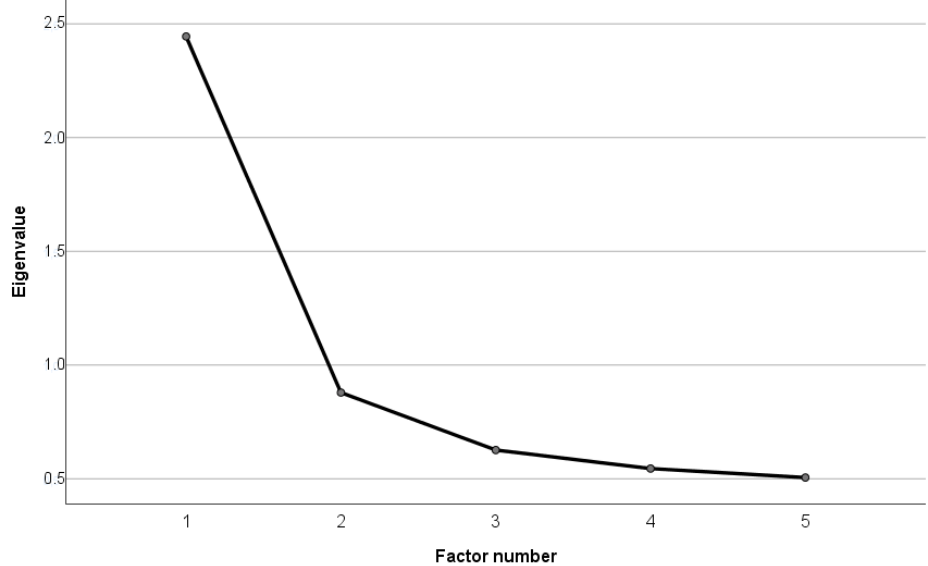
Figure 2. Results of scree plot of explanatory factor analysis of SCIUS.